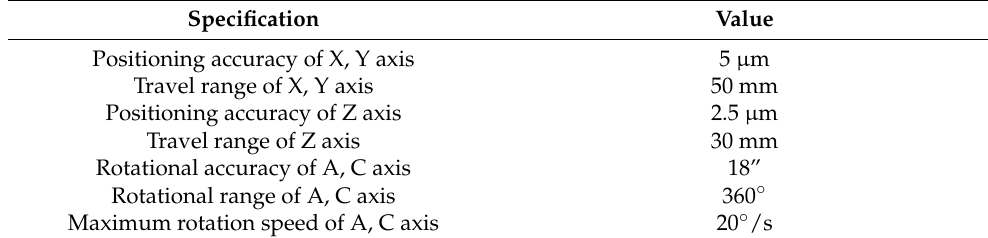
Figure 2. ( a ) Designed and ( b ) realized five-axis motion platform. Table 1. Specifications of five-axis motion platform.